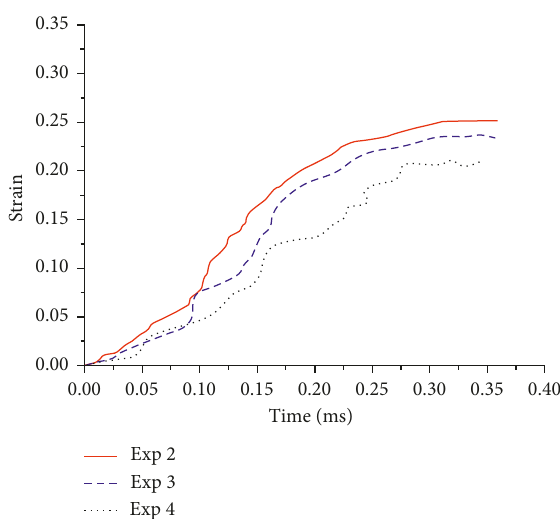
Figure 20: Strain-time curves of the sandwiched materials in Tests 2, 3, and 4.